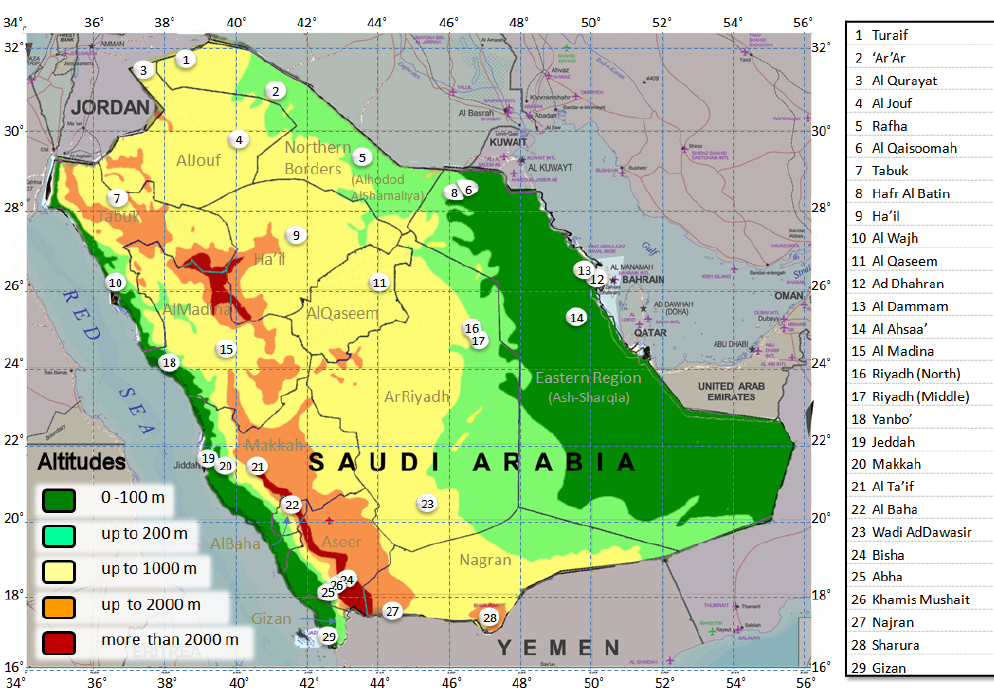
Figure 2. Geographic map of Saudi Arabia [22].